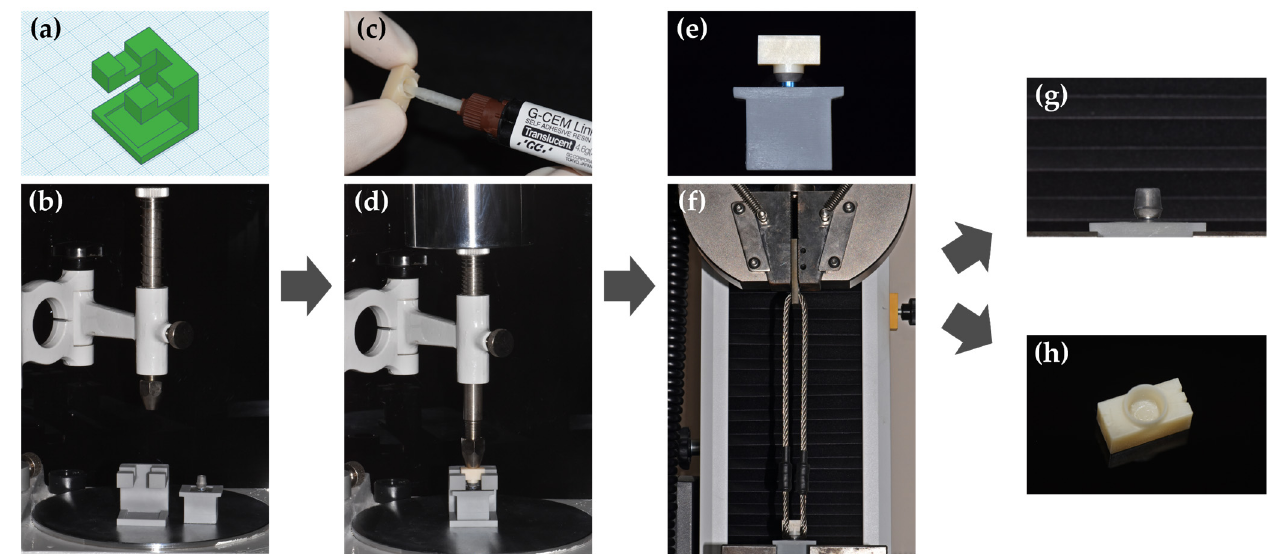
Figure 5. The process of testing retentive strength (RS) between the zirconia crown and the titanium abutment. ( a ) CAD data of the positioning stand. ( b ) 3D-printed positioning stand and titanium abutment on a surveyor. ( c ) Application of G-CEM LinkAce inside the zirconia crown. ( d ) Zirconia crown and titanium abutment bonded with the resin cement by a force of 50N using a surveyor. ( e ) Zirconia crown-titanium abutment assembly after light polymerization. ( f ) Fixing the assembly to the Instron machine and placing the wire on the zirconia crown. ( g ) Debonded titanium abutment after the RS test. ( h ) Debonded zirconia crown after the RS test.